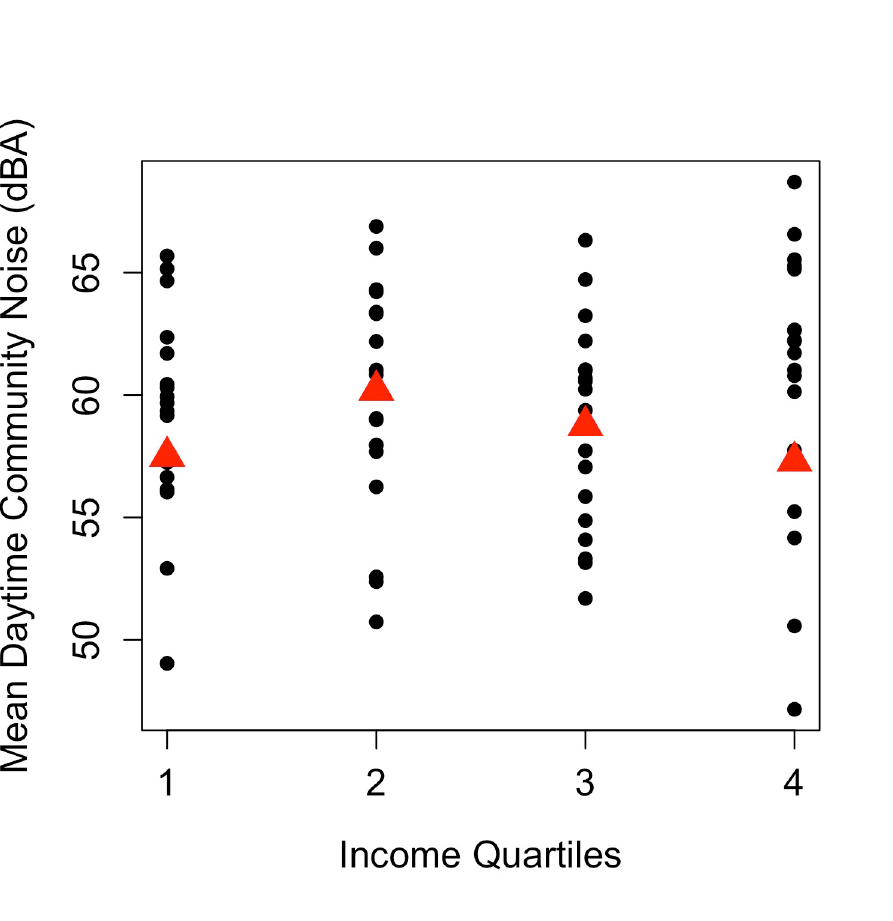
Fig 2. Association between quartiles of community per capita income and mean community daytime noise.